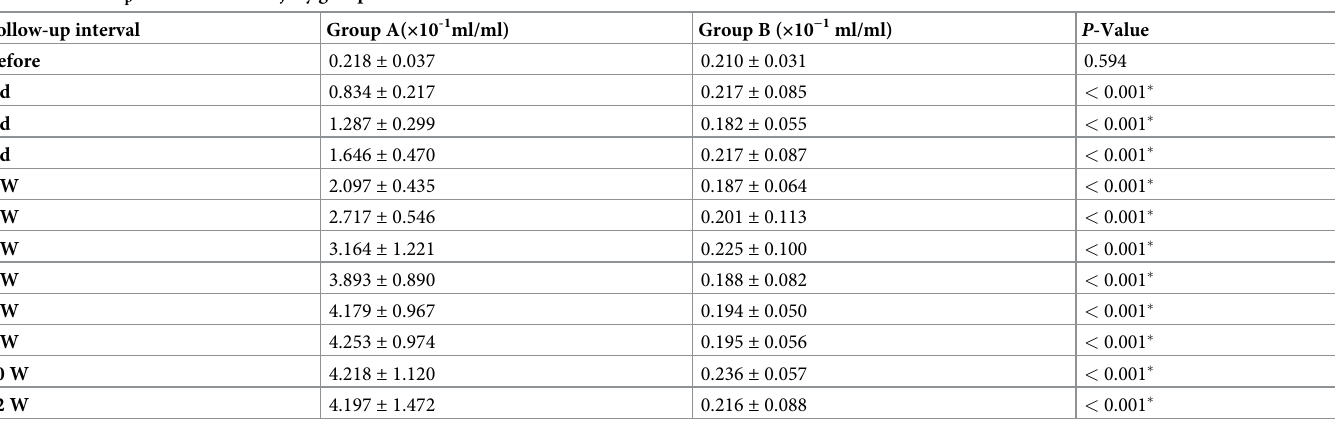
Table 3. Mean V p values for each injury group. Follow-up interval Before